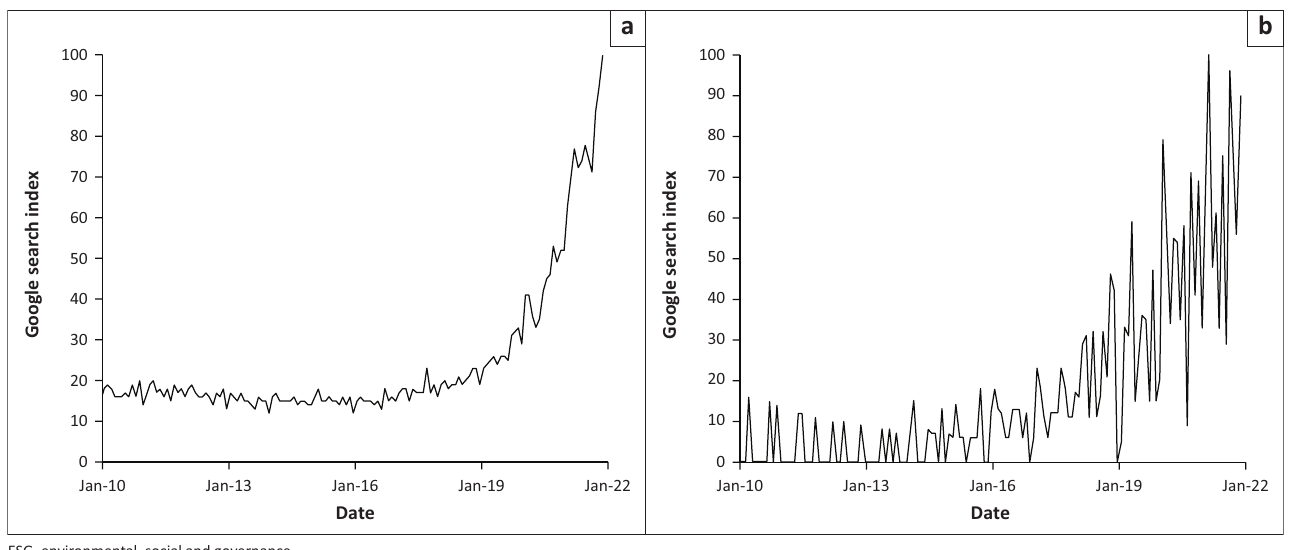
ESG, environmental, social and governance. FIGURE 1: Google search index for the phrase (a) ‘environmental, social and governance’ and (b) ‘environmental, social and governance investing’ since 2010. The value 100 represents maximal